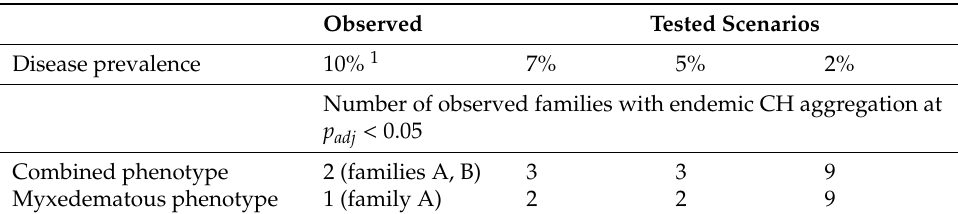
Table 5. Observed and tested disease prevalence scenarios for the binomial probability